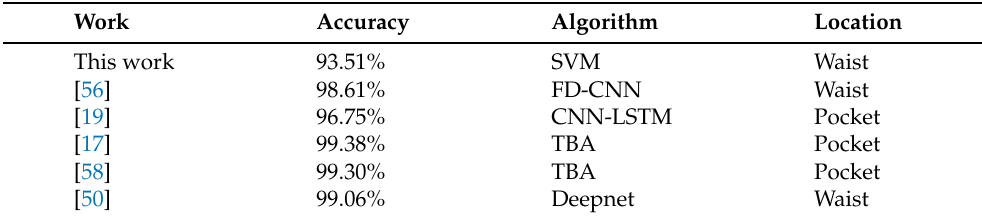
Table 8. Comparison of different fall detectors with the one proposed in this